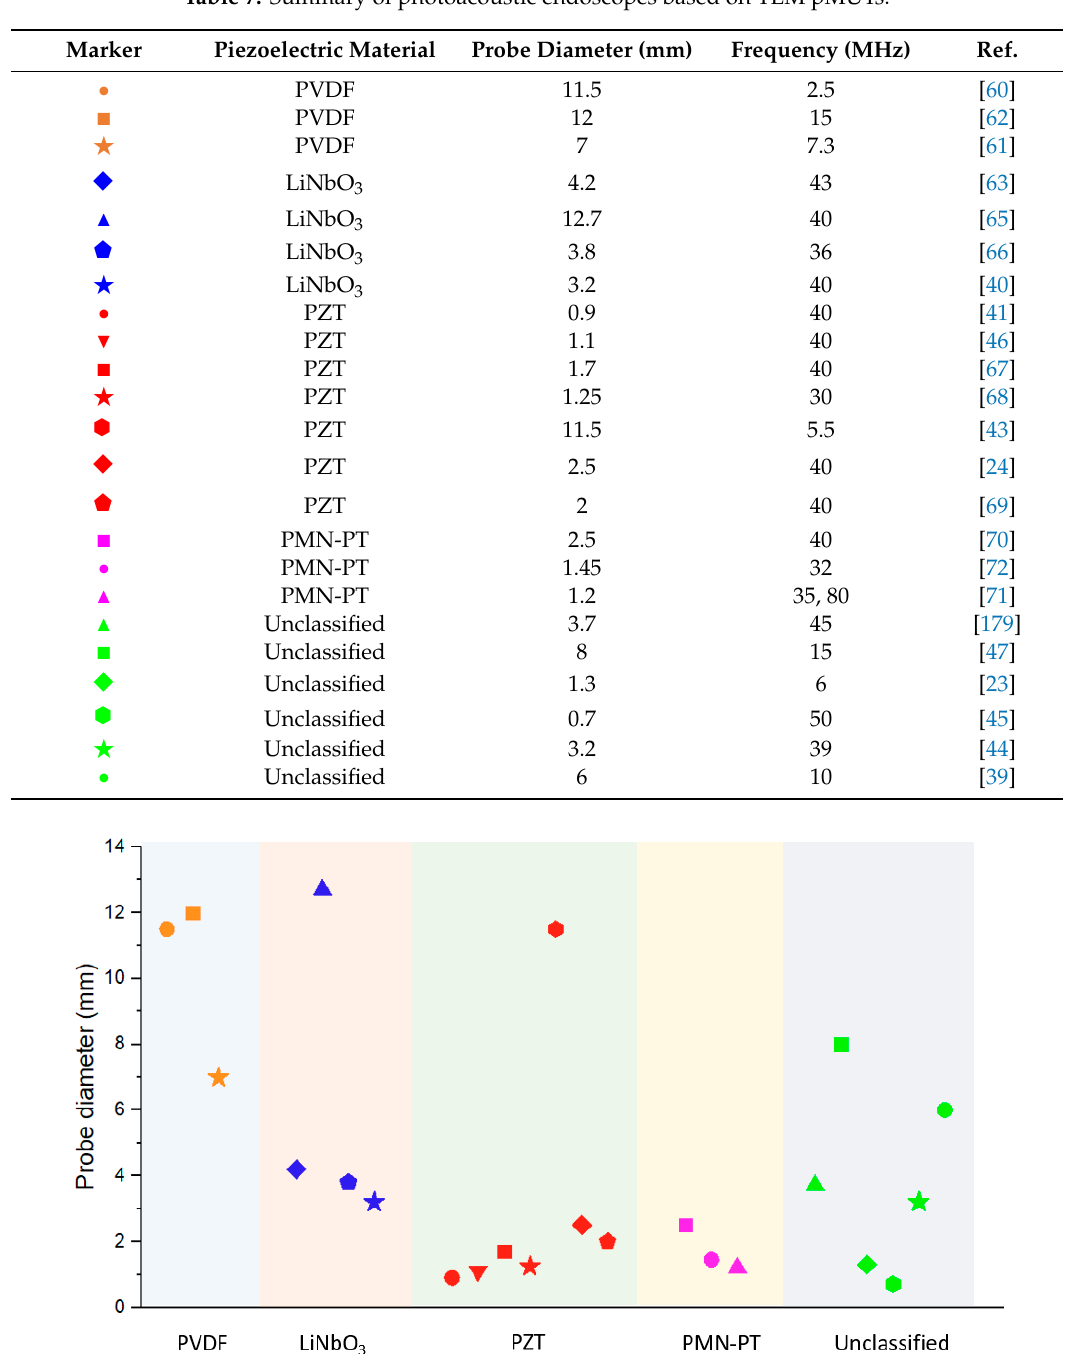
Figure 30. A comparison of the sizes of photoacoustic endoscopes based on TEM pMUTs (the markers are listed in Table